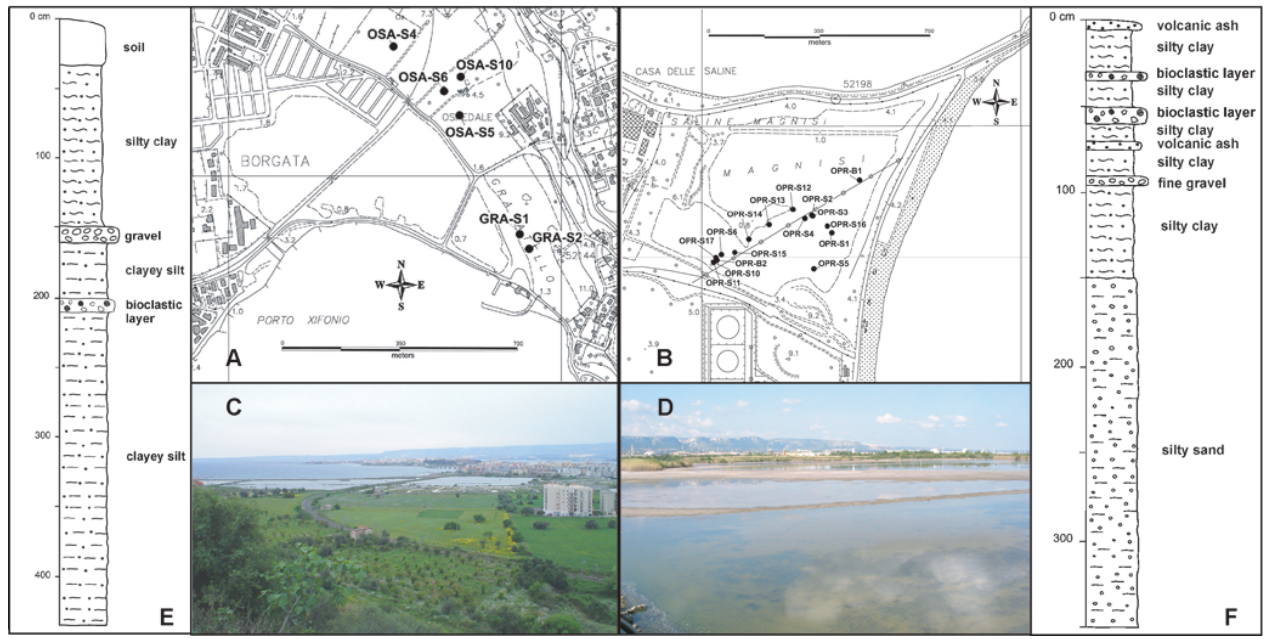
Fig. 2. Locations of cores collected at the Augusta Hospital (A) and Priolo Reserve (B) sites (topographic maps from the Regional Technical Cartography, RTC scale 1:10000). Views of the Augusta Hospital ( C , looking S) and Priolo Reserve ( D , looking N) areas. Schematic sedimentary sequences for Augusta (E) and Priolo (F)